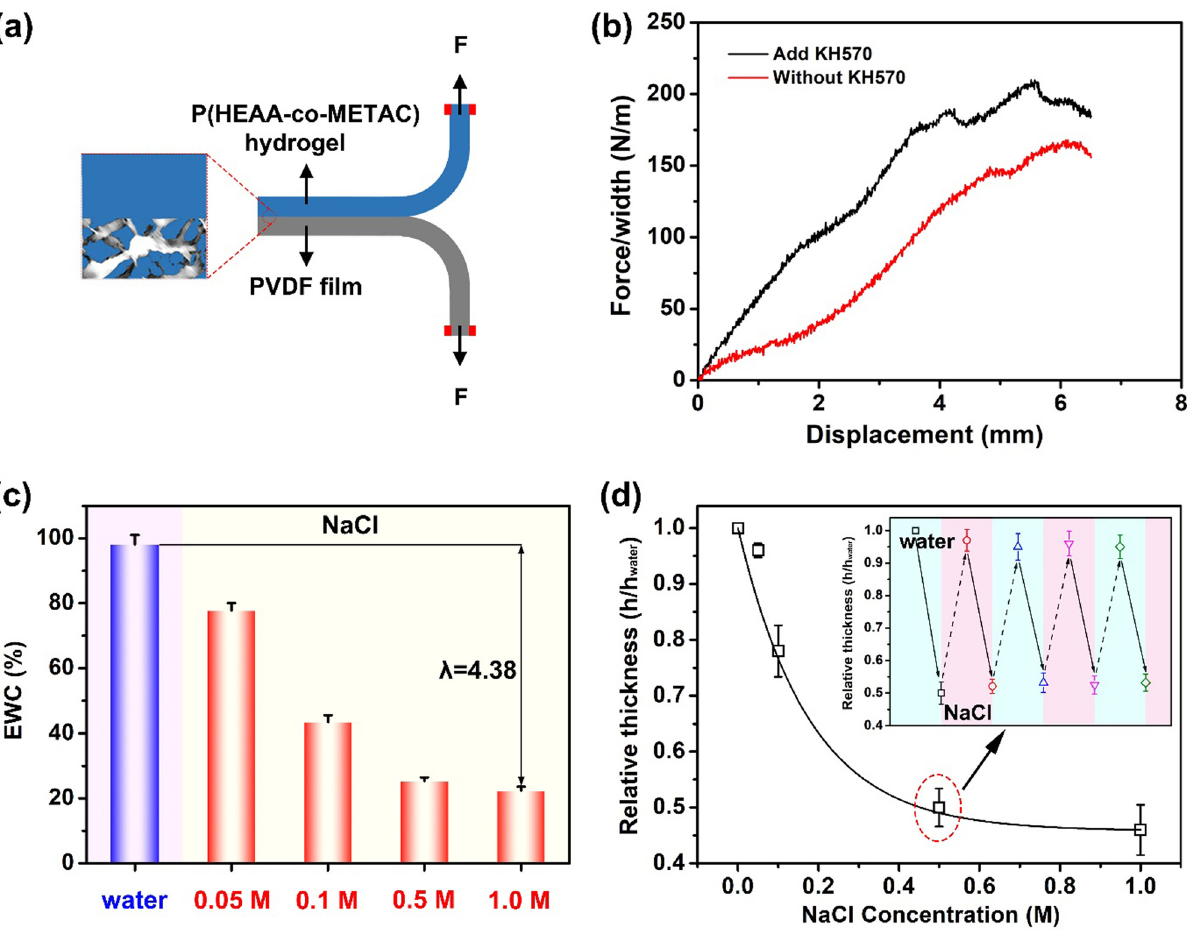
Figure 3: ( a ) Schematic illustration of 180° peeling processes of the hybrid hydrogel coating - PVDF fi lm. ( b ) Peeling curves of force per width of the hydrogel layer versus the displacement. ( c ) EWC of the P ( HEAA - co - METAC ) hydrogel in water and NaCl solution with di ff erent concentrations ( 0.05 – 1.0 M ) . ( d ) The relative thickness h / h water of the P ( HEAA - co - METAC ) hydrogel in NaCl solution with di ff erent con - centrations ( inset: the changes of h / h water by repeat switching stimulus between water and 0.5 M NaCl )